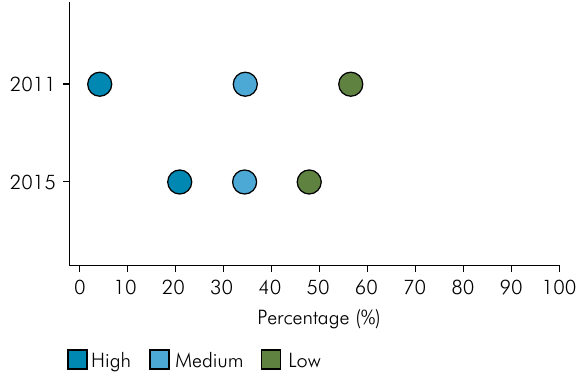
Figure 1. Reduction in inequality of dental caries prevalence according to social class, among adults residing in Piracicaba, SP, Brazil,